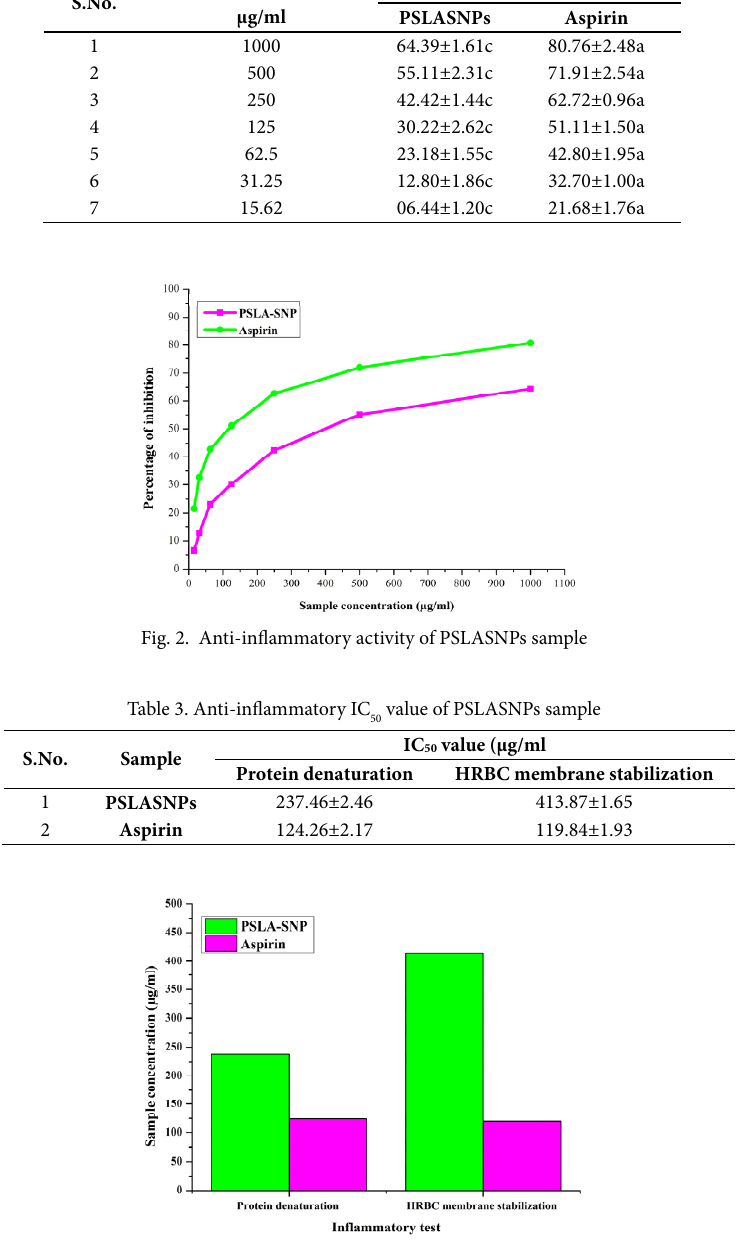
Fig. 3. Anti-inflammatory IC